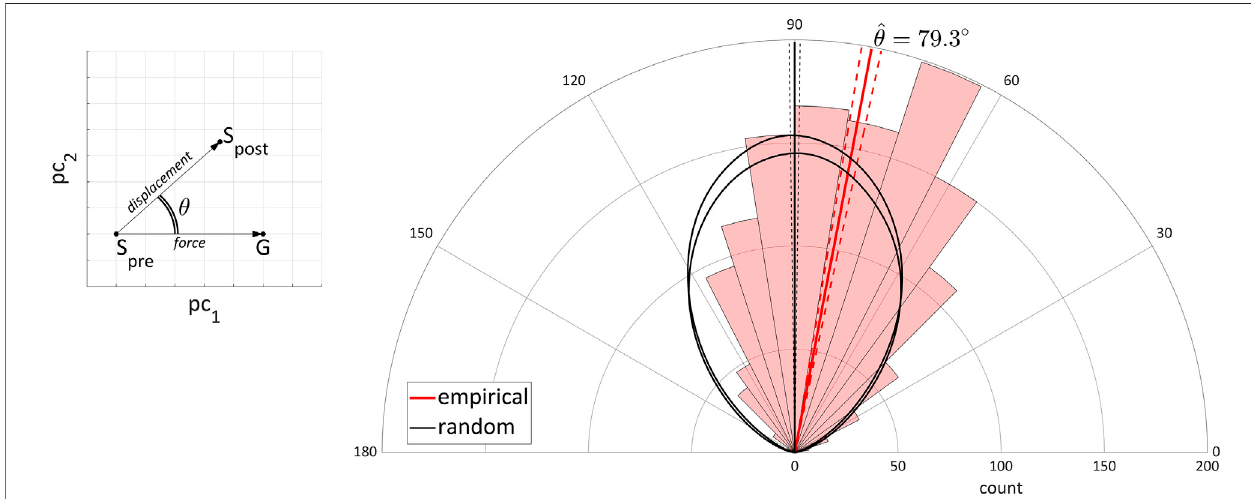
FIGURE11| Distributionofanglesbetweeninteraction forceanddisplacementvectors.Left:schematicillustrationofinteractionforceand displacement vectorsin two dimensions. Right: polar histogram (empirical data) and density (random data) of angles calculated from fi rst six principal components of vowel state space. Red lines: mean and ±2.0 s. e. of empirical angles. Black lines: ±2.0 s.d. of mean angle over 1,000 random